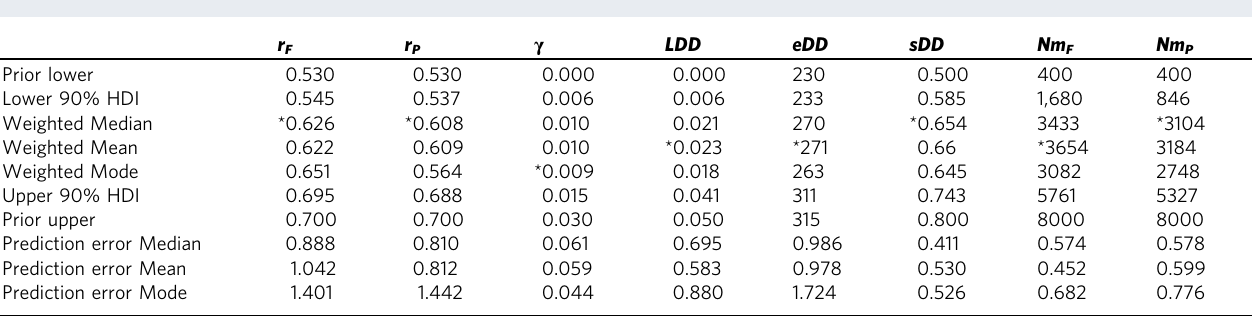
Fig. 2 ABC analysis of the most signi fi cant parameters. a – c ) The light gray area indicates the posterior distribution of the parameters, the dotted line shows the prior distribution. d – f ) Cross-validation results showing the accuracy of the parameter estimation. The dots show the estimated value against the “ true ” value used in the simulation; the closer the points are to the black line, the more accurate the retrieved true value is. A linear regression between true and estimated values is shown in red. Table 3 Parameter estimation